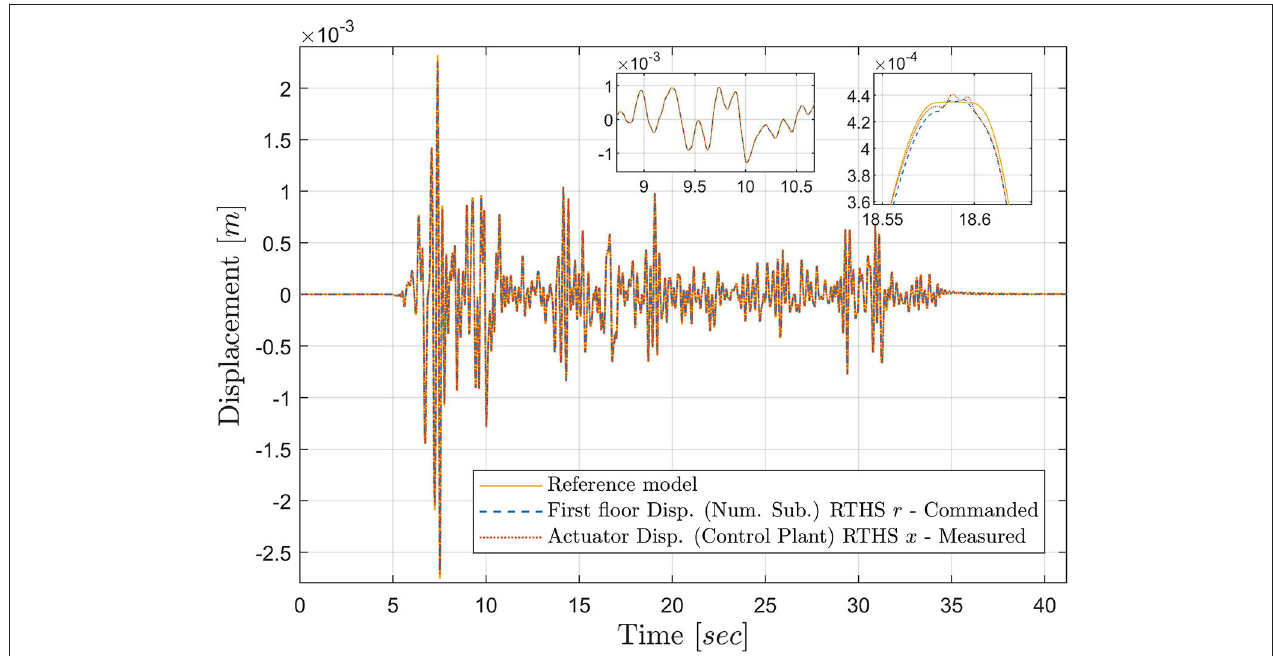
FIGURE 12 | Displacement responses of the reference model, the numerical substructure, and control plant in